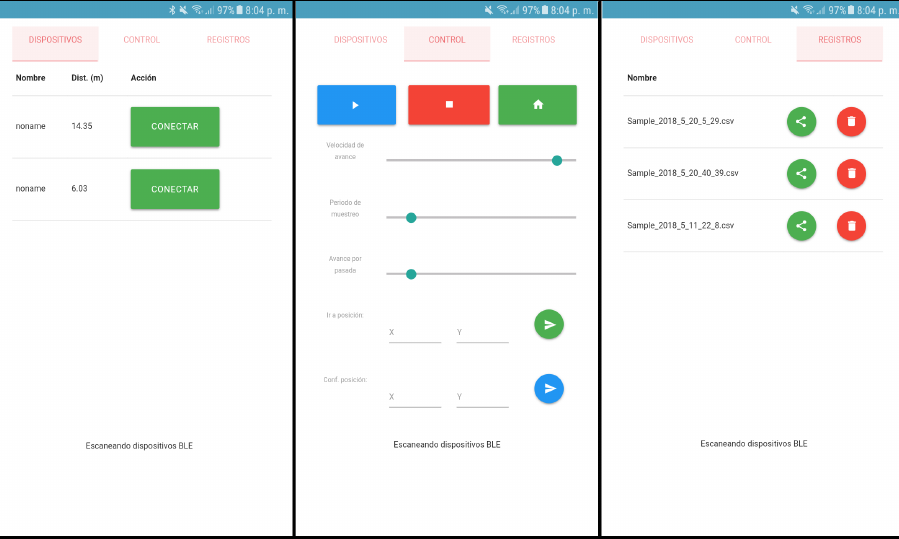
Figure 4. Android application